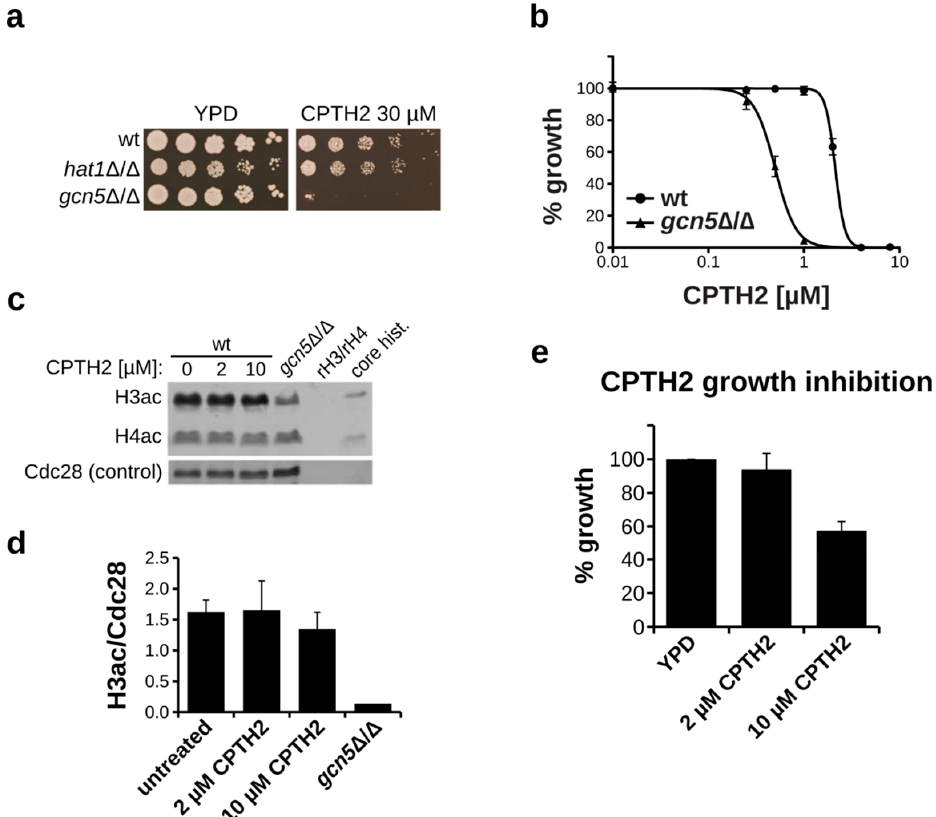
Figure 2. CPTH2 inhibits C. albicans independently of Gcn5. ( a ) Spot dilution assay of the indicated C. albicans strains on YPD plates. The gcn5 ∆ / ∆ strain shows increased sensitivity to CPTH2. ( b ) Liquid growth inhibition assay in YPD medium. C. albicans wt and gcn5 ∆ / ∆ cells were incubated with the indicated concentrations of CPTH2 for 24 h prior to OD 600 measurement. ( c ) Immunoblot of histone H3 and H4 acetylation upon treatment with CPTH2. Cells were treated with the indicated concentration of CPTH2 for 4 h prior to SDS-Page analysis followed by immunoblotting with an anti-acetyl lysine antibody. Cdc28 served as loading control. Unacetylated recombinant histones (rH3, rH4) and chicken core histones were used as negative and controls, respectively. ( d ) Quantification of histone H3 acetylation levels upon CPTH2 treatment using immunoblotting as described above ( c ). ( e ) Growth inhibition by CPTH2 of C. albicans cultures used for immunoblotting described in ( c ). OD 600 was measured after 4 hours of treatment. ( b , d , e ) Data shown are mean ± sd of three biological replicates.